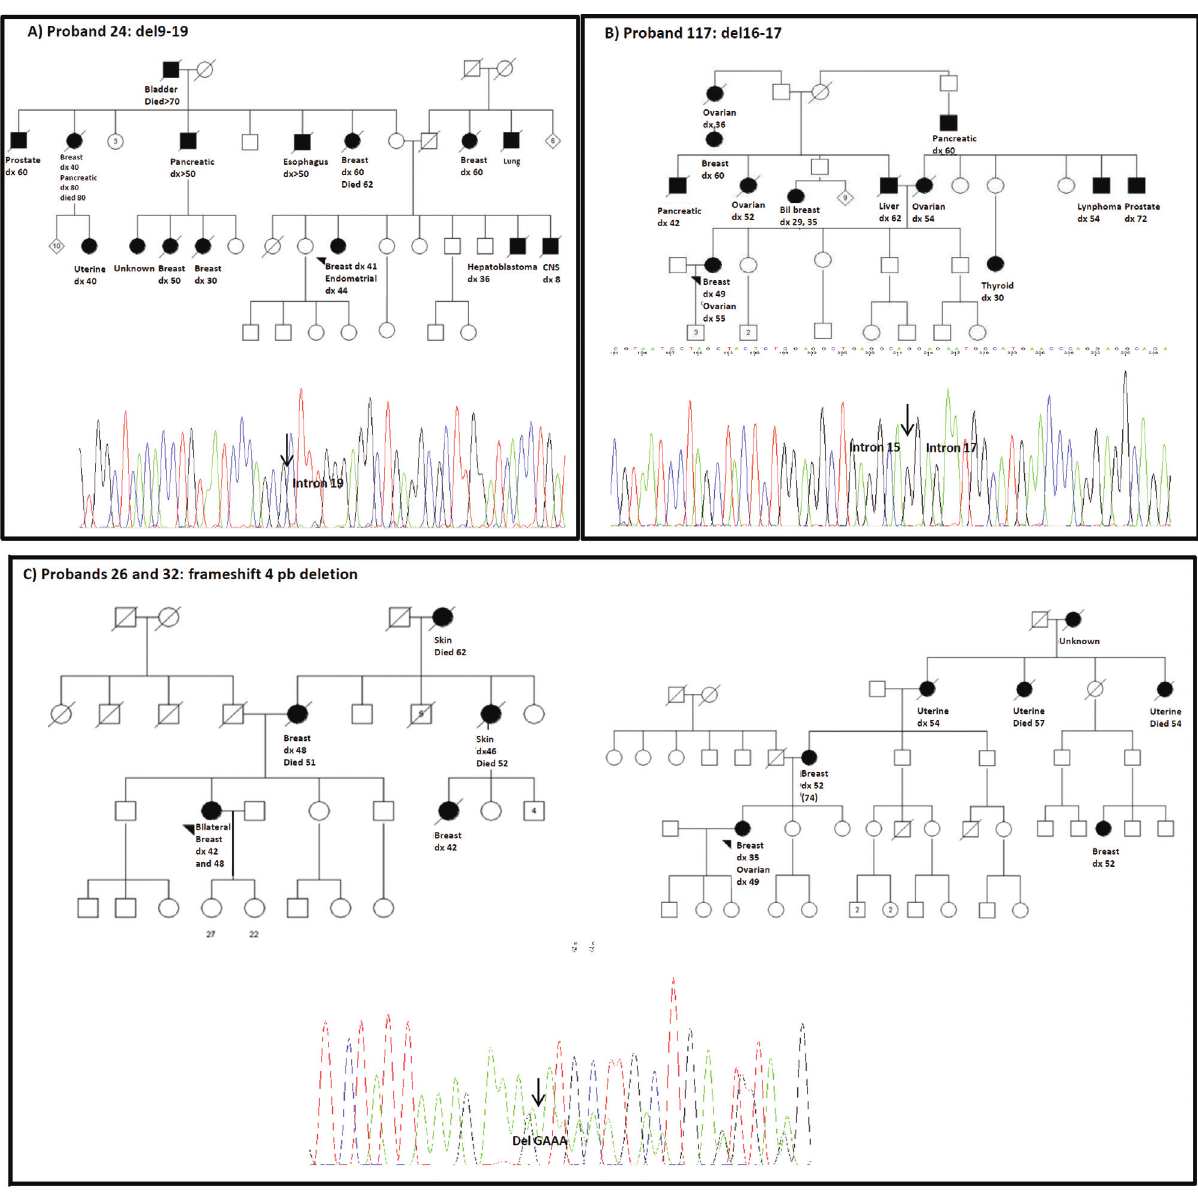
Figure1 -Pedigreesofthemutationcarriers.PanelsA,BandC:familieswithgermline BRCA1 mutationsidentifiedbyMLPAasfirstmutationscreening strategy. Panels D, E and F: families with germline c.156_157insAlu- BRCA2 mutation identified by